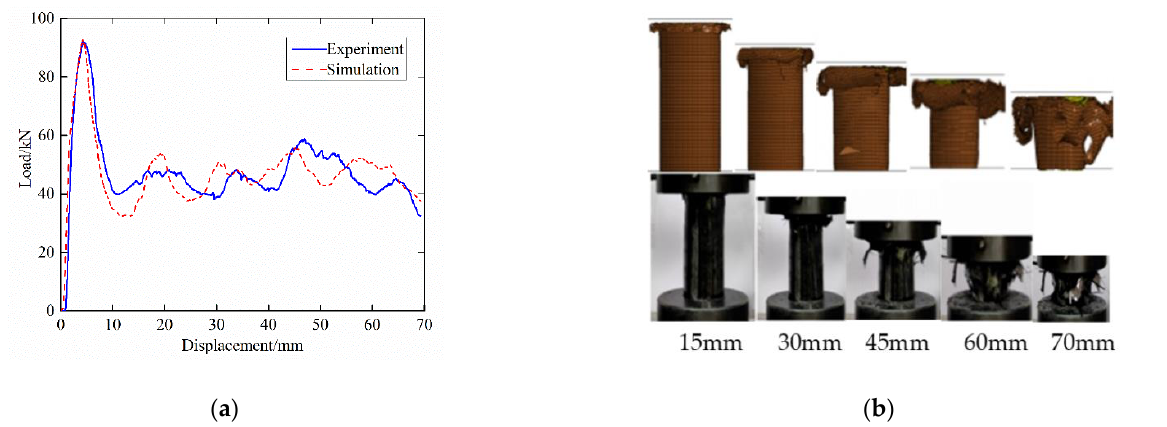
Figure 9. Simulation and experiment comparison of the CFRP-Al hybrid tube: ( a ) load–displacement curve; ( b ) comparison of deformation modes.